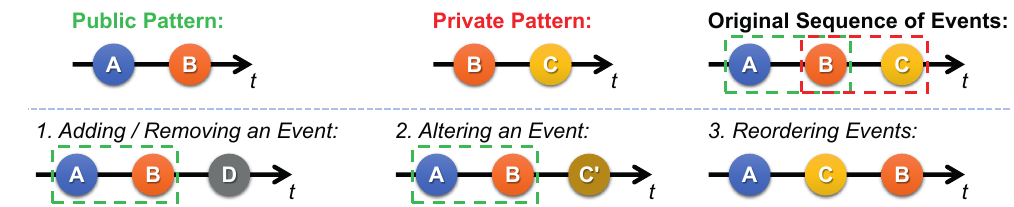
Figure 13. Application of Obfuscation Techniques to Conceal Private Patterns in a Data